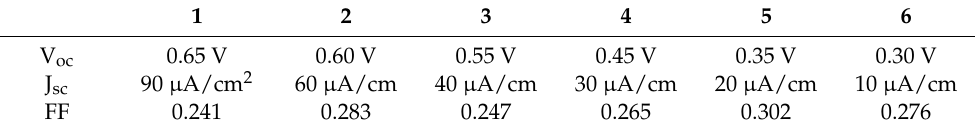
Figure 7. Performance of different thickeners in electrolyte layer (1:6 wt.% xanthan gum with water; 2:5 wt.% Simulgel with water; 3:6 wt.% NaCMC with water; 4:3 wt.% Stellmittel with water; 5:20 wt.% PVP10000 with water; 6:25 wt.% Luvogel with water). Table 3. V oc , Jsc, and FF for Figure 7.